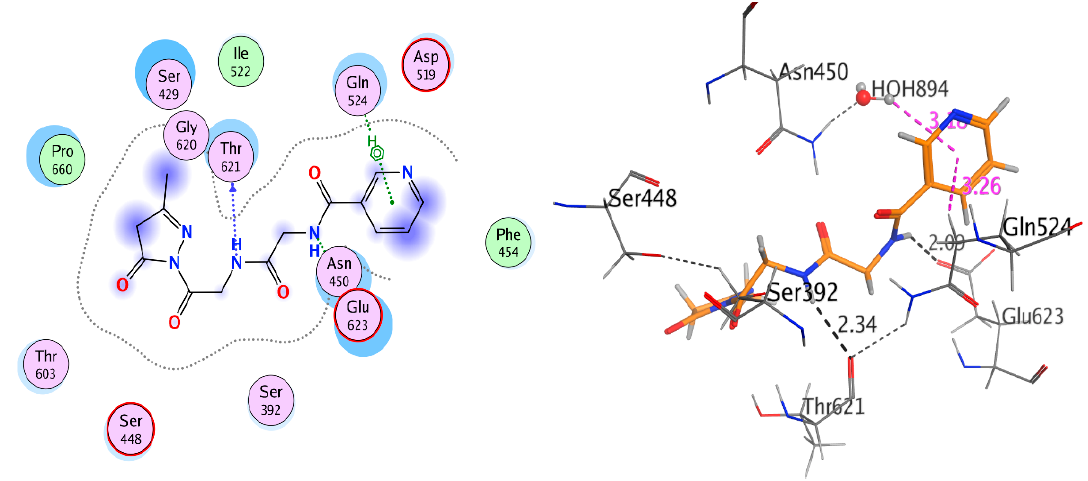
Figure 6. 2D and 3D interaction of compound 9 with 3VSL.